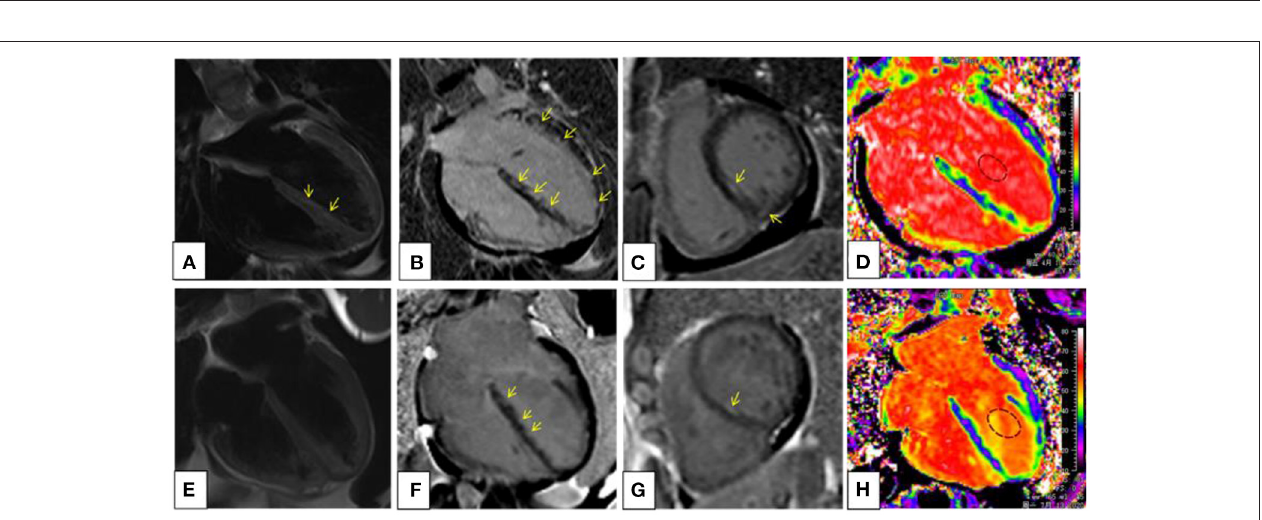
FIGURE 3 | Cardiac magnetic resonance (CMR) imaging at the baseline (A–D) and after 3-month prednisone and immunosuppressant therapy (E–H) . T2-weighted image (A) demonstrated small patches of high-signal intensity in mid-wall and subendocardial regions of the interventricular septum, revealing myocardial edema. On the four-chambered (B) and basal short-axis (C) view of late gadolinium enhancement (LGE), multiple foci of high-signal intensity were scattered diffusely in mid-wall and subendocardial regions in a nonischemic pattern. An extracellular volume (ECV) map (D) showed heterogeneously elevated ECV fraction of the left ventricular myocardium and septum; the global ECV fraction was 34.6%. On posttreatment CMR, it showed complete remission of the myocardial edema (E) and significantly reduced LGE (F,G) . The global ECV fraction decreased to 29.6% (H) .